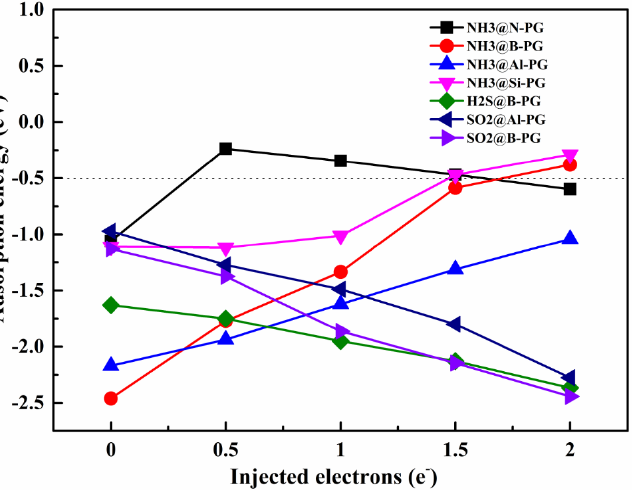
Figure 9. Adsorption energies of NH 3 , H 2 S, and SO 2 over doped PG as a function of the injected negative charges. negative